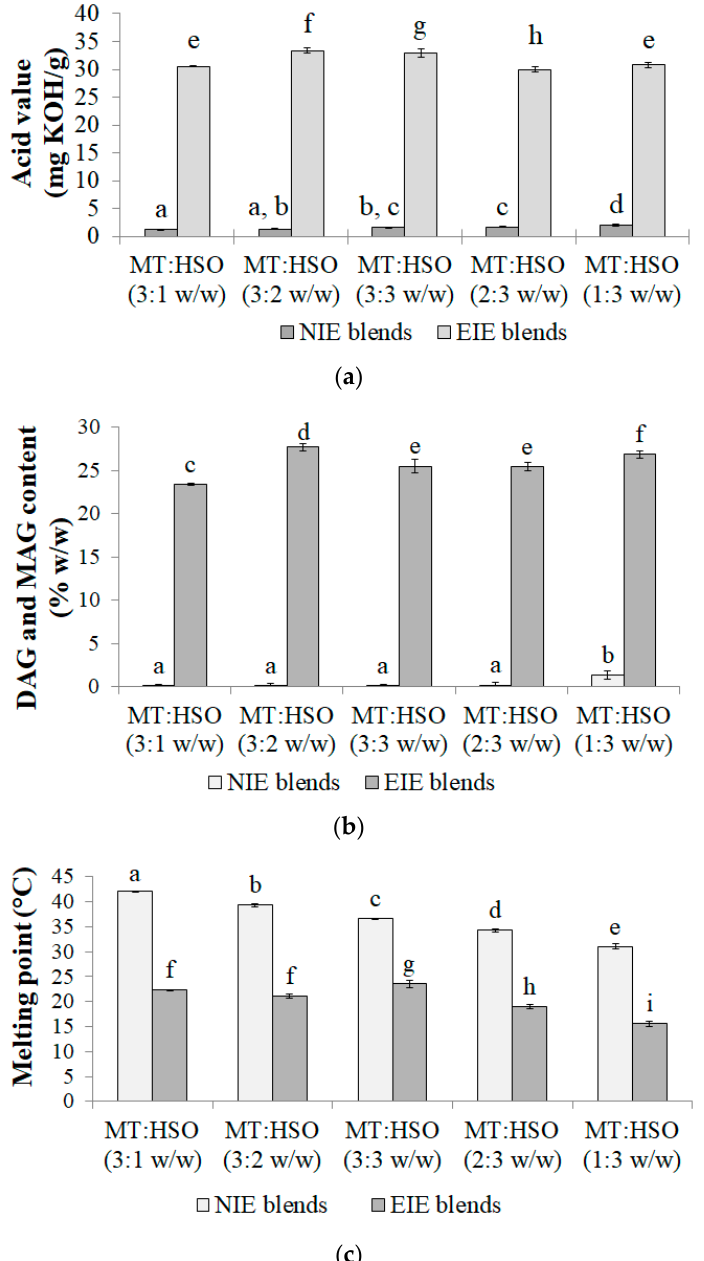
Figure 1. Fat blends characteristics: ( a ) acid value, ( b ) DAG and MAG content, ( c ) melting point. Different letters indicate significantly different values ( p < 0.05).